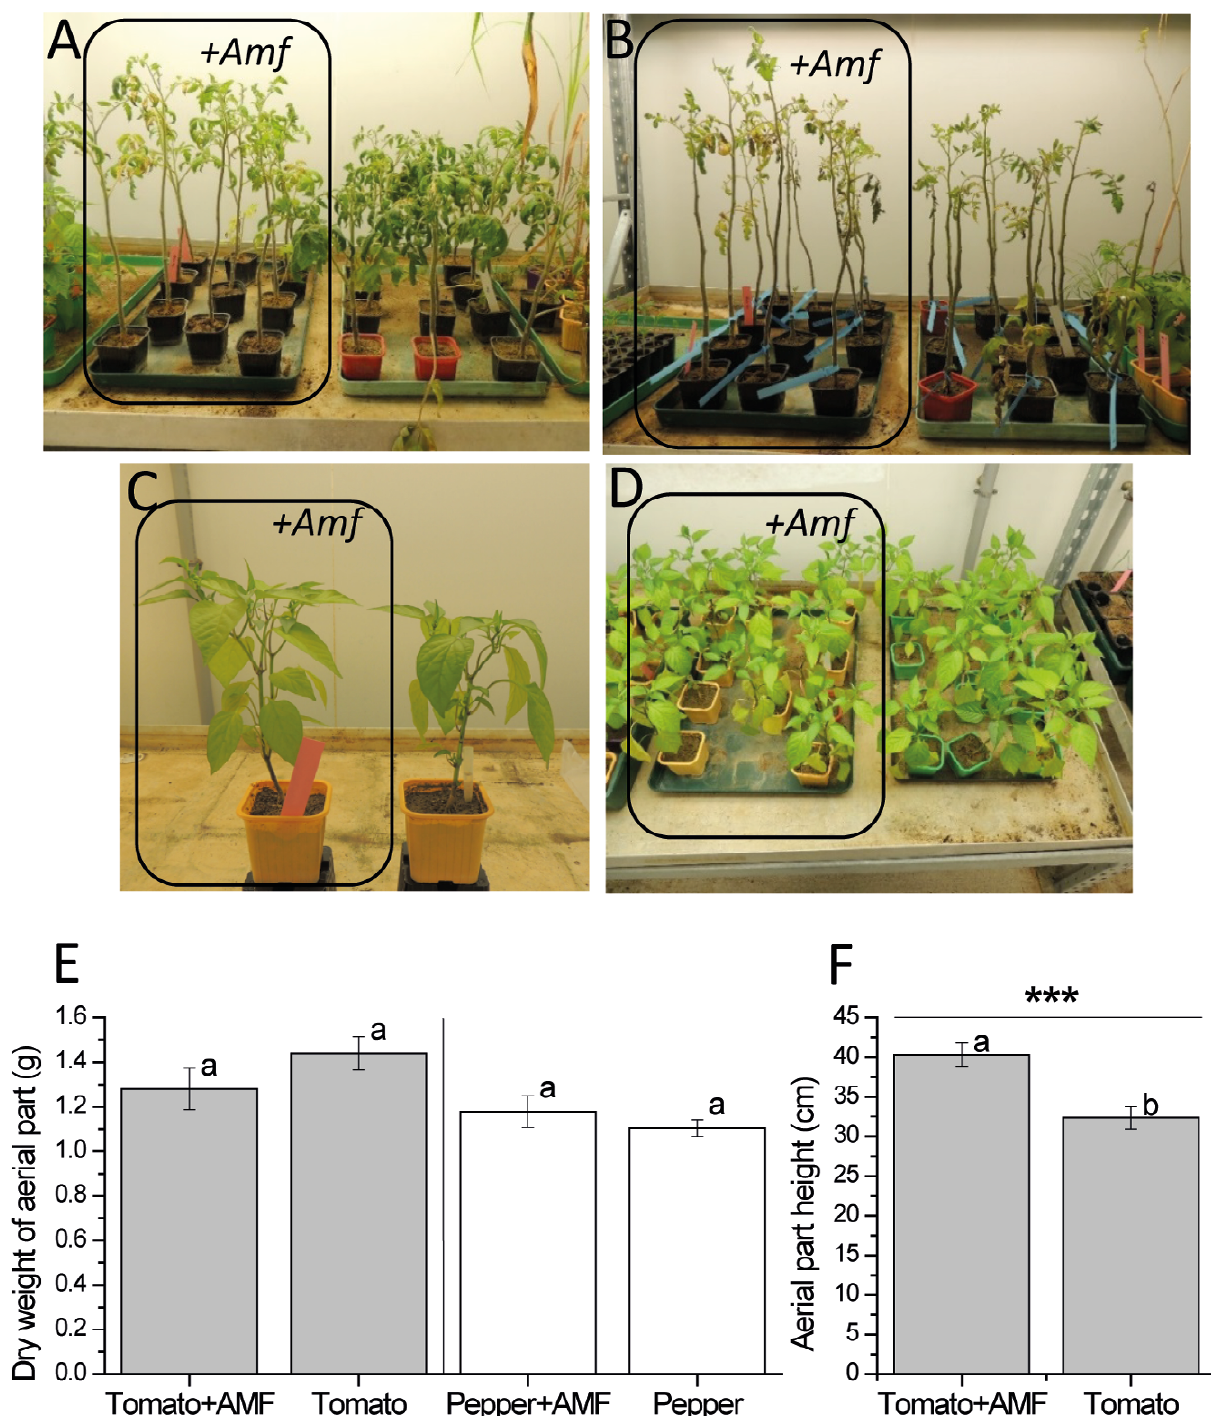
Figure 2. Plants grown in growth chambers for evaluating AMF effects on root knot nematode (RKN) development. Tomato plants at 4 weeks (micrograph A) and 6 weeks (micrograph B) after RKN inoculation. Pepper plants (micrographs C and D) 6 weeks after inoculation with RKN. Means (and standard errors: n ≥ 9) of shoot dry weights (Graph E) and plant heights (Graph F) for 12-week-old tomato and pepper plants 6 weeks after inoculations with J2s of Meloidogyne incognita . Means accompanied by different letters are significantly different ( P < 0.001 (***), Student’s